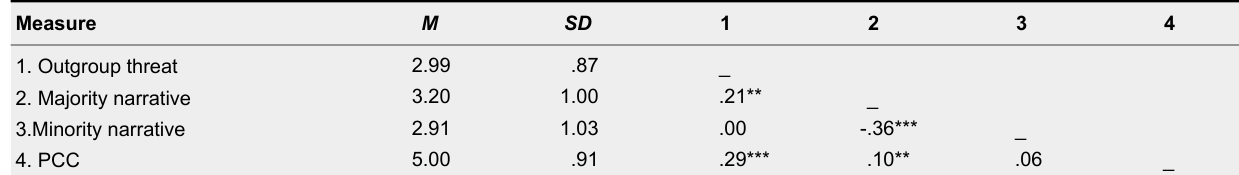
Means, Standard Deviations and Bivariate Correlations Between all Measures for the Full Sample